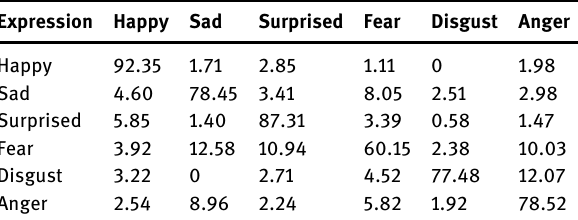
Table 4: Confusion matrix of the FER2013 dataset Expression Happy